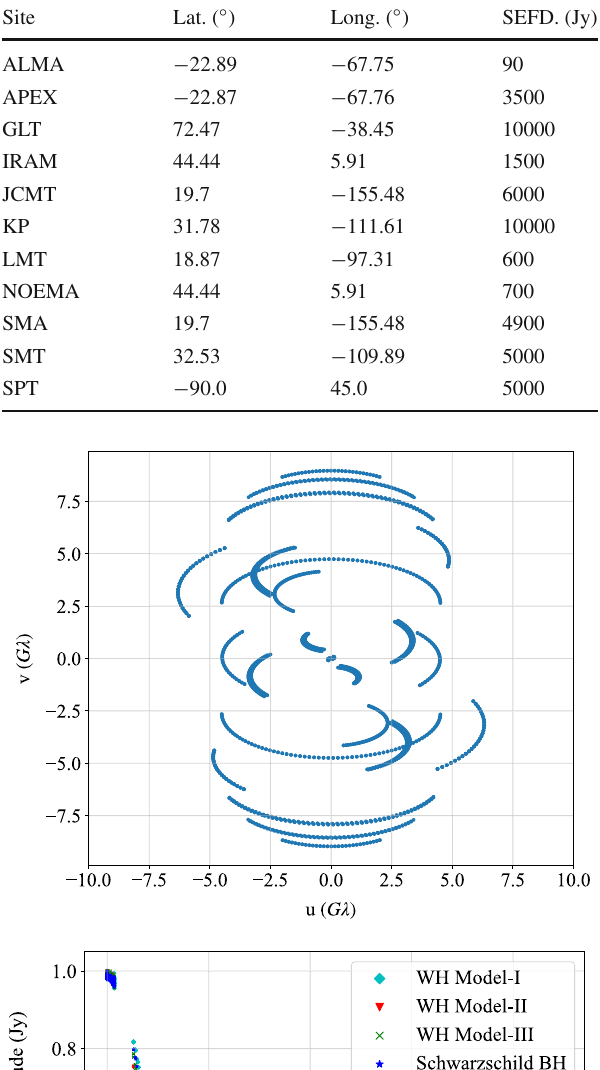
Table 2 Locations of existing sites (2021) in the event horizon tele- scope array configuration Site